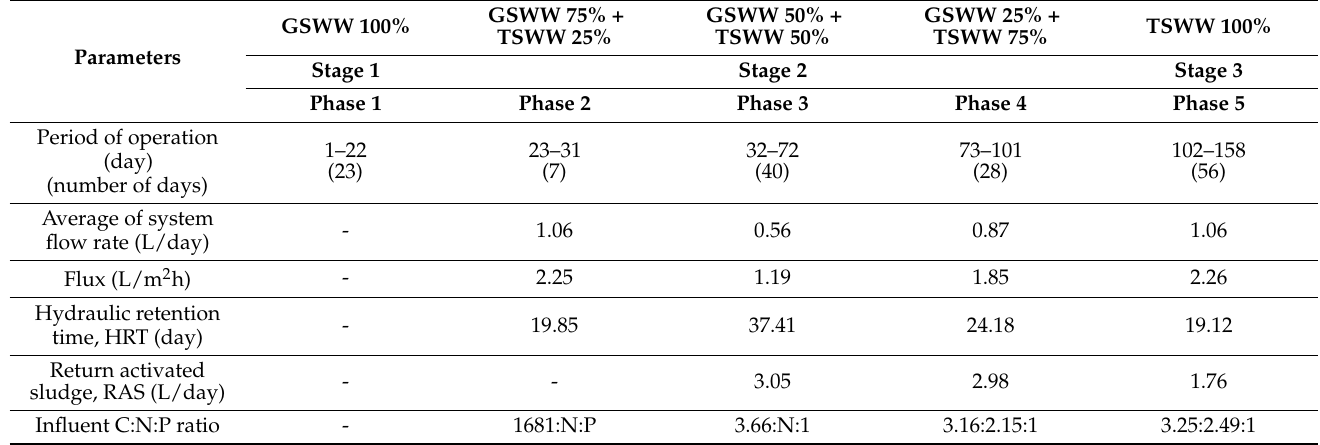
Table 4. Average feed characteristics during each process